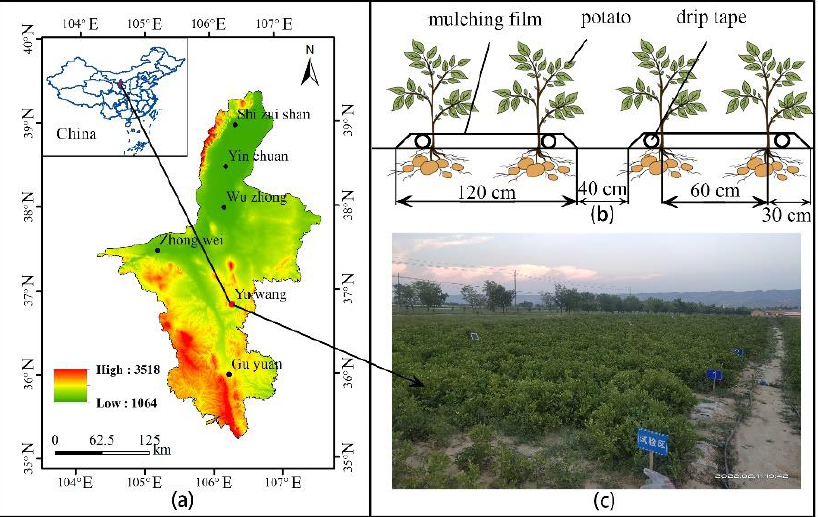
Figure 1. (a) Location of the experimental site, (b-c) Potato planting pattern and drip irrigation belt arrangement diagram.